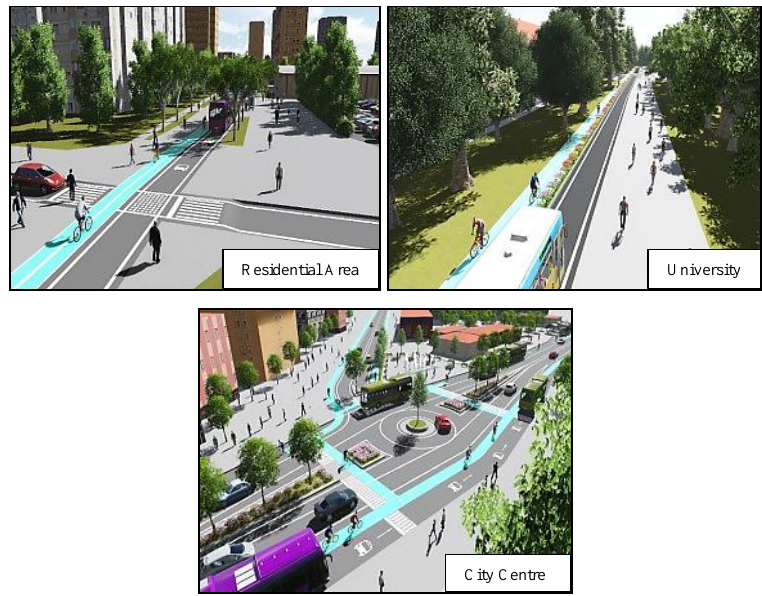
Figure 5. The Turkish locations as they might look in Improve Vision.